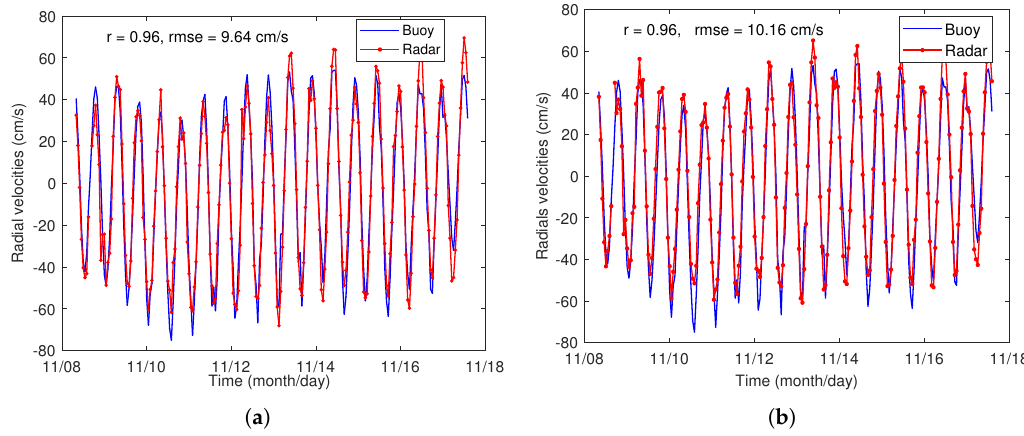
Figure 12. Comparison of the radial velocities extracted involving the extra manipulation with those recorded by the buoy (Figure 4) for DOSH. The extra manipulation is defined as multiplying the same constant factor to the sea echoes received by the cosine and sine loop after performing the TLSCR calibration procedure. ( a ) the value of the constant number is equal to 0.2 ( µ = 0.2); ( b ) the value of the constant number is equal to 20 ( µ = 20). Correlation coefficient (r) and root-mean-square error (rmse) are shown in the top of each